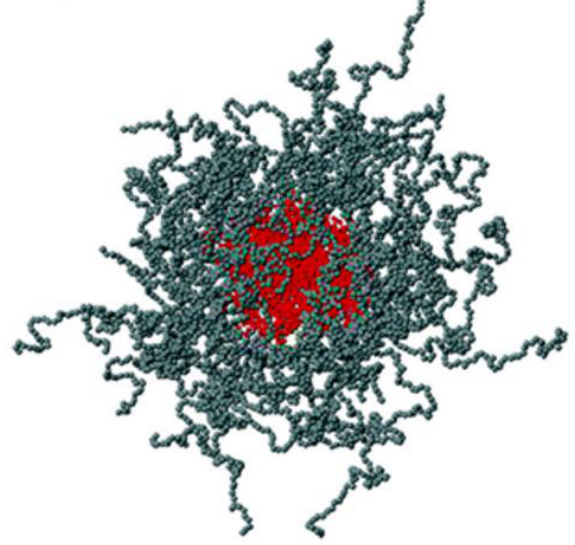
Figure 1. Schematic representation of poloxamer 407-micelles obtained by molecular dynamics in the CGIS (coarse-grained implicit solvent) model. In the CGIS model, water is treated as an implicit viscous solvent, while polymer chains are represented as bead-spring polymers, where each bead represents an oxyethylene (OE) or a oxypropylene (OP) monomer. The micelle core is made up of polyoxypropylene (POP) blocks, while the corona is formed by the polyoxyethylene (POE) blocks. Reprinted from [56] with permission from American Chemical Society, 2006.